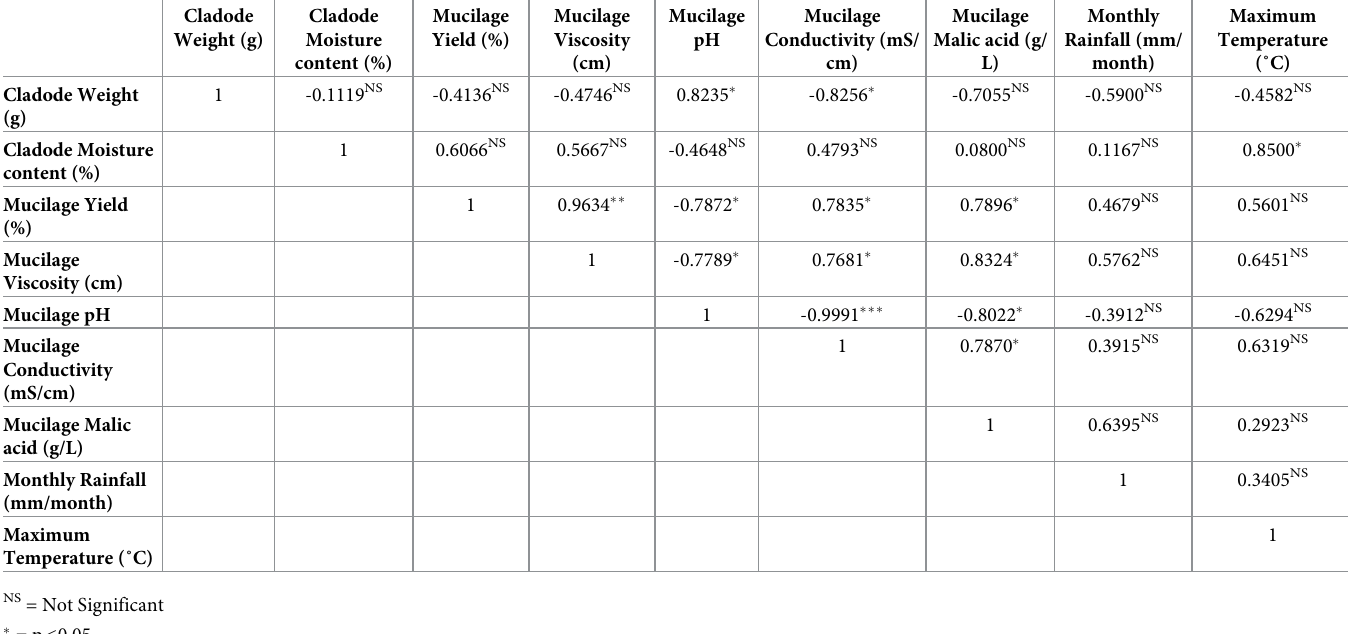
Table 2. Pearson correlation coefficients between rainfall and maximum temperatures and the weight and moisture content of cladodes harvested over six months (February to August 2015) and the yield, viscosity (Line-spread), pH, conductivity and malic acid content of mucilage extracted from cladodes over six months (Feb- ruary to August